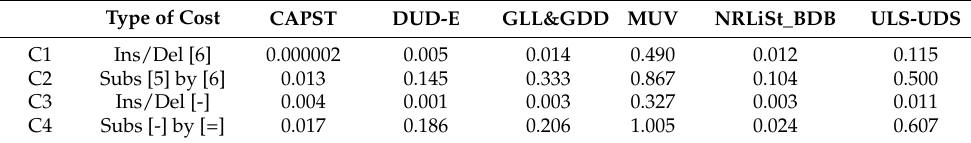
Table 5. Costs obtained in [35]. Each row corresponds to one of their experiments.